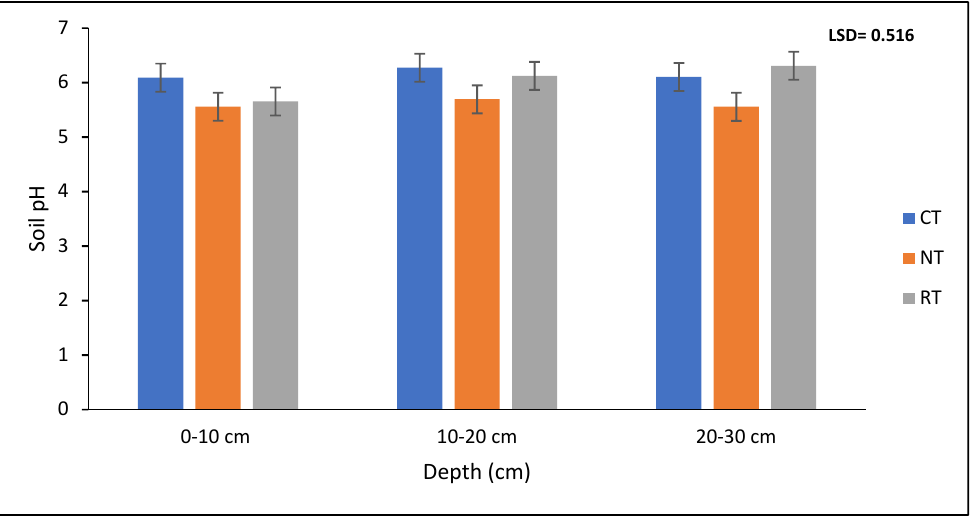
Figure 3. Soil pH at three different sampling depths (0–10, 10–20, 20–30 cm) after 17 years of trial establishment. CT = conventional tillage, RT = rotational tillage, NT =